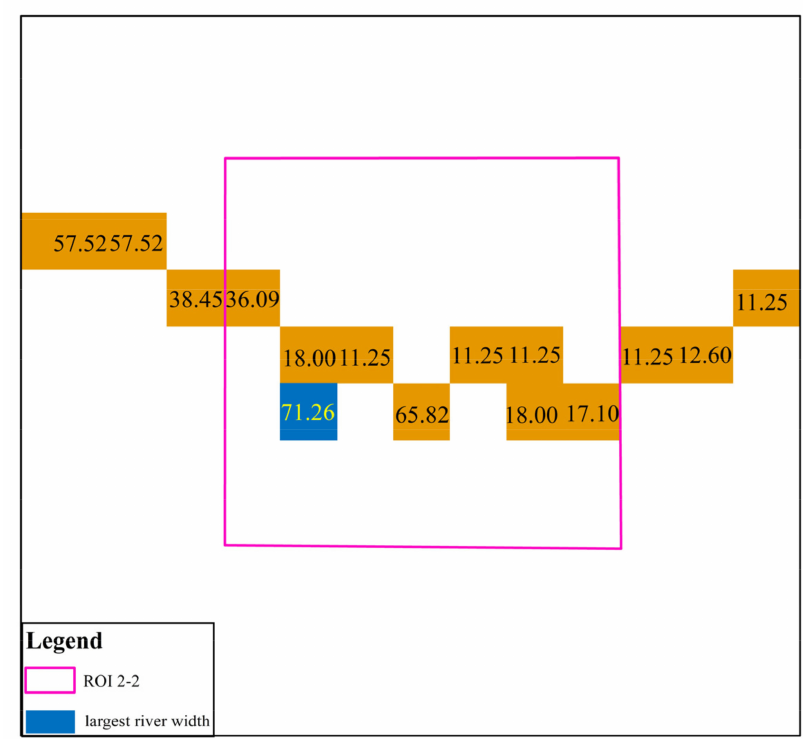
Figure A1. Selection of representative width value based on width from MERIT HYDRO in this study. River centerline pixels were first identified, and each had corresponding river width information. As for the selected river reach, there are a series of river centerline pixels. Among them, the one that has the largest river width was selected, and this largest river width was taken as the river width of the river reach (site identified by the pink ROI 2-2 for example, the white background stands for 0